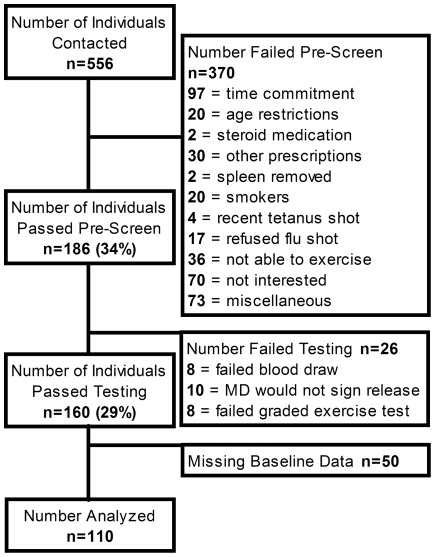
Immune Function Intervention Trial CONSORT diagram.